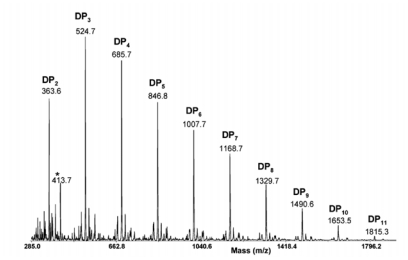
MALDI-TOF MS of deacetylated chitooligosaccharides obtained from ultrasonically treated chitosan. Reprinted with permission from Biomacromolecules. 2009, 10, 1203–1211. Copyright 2010, American Chemical Society [226].